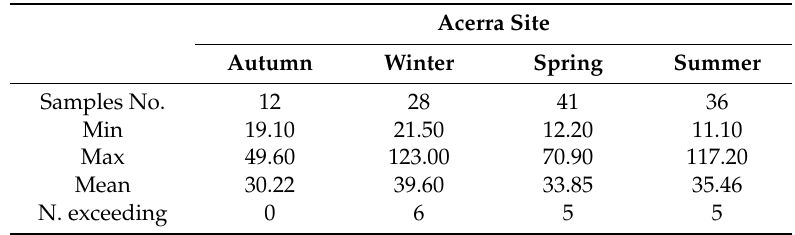
Table 4. Particular Matters (PM) 10 mass concentration, Min, Max and Mean ( µ g m − 3 ) in autumn,